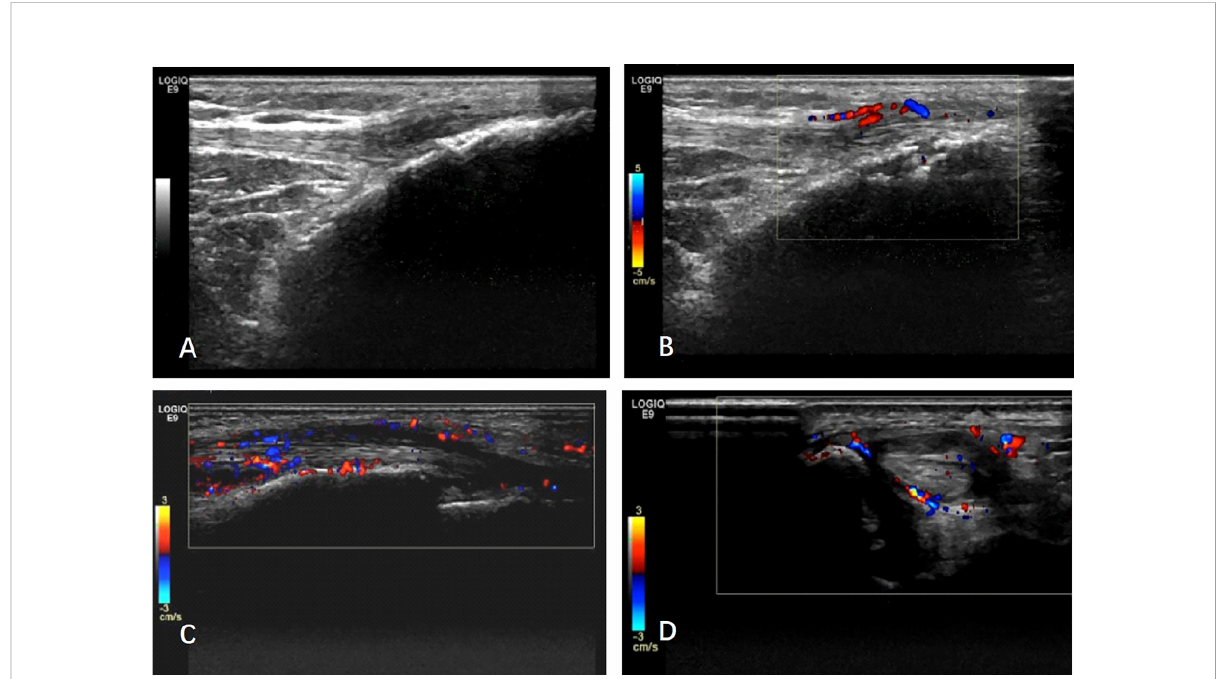
FIGURE 1 The typical ultrasound image of psoriatic arthritis: (A, B) Enthesitis: (A) longitudinal scan of patellar tendon at its distal insertion into the anterior tibial tuberosity. Note the presence of hypoechoic areas, entheseal thickening together with an enthesophyte. (B) B-mode signs of enthesitis are detectable. The image shows evidence of power Doppler signal at the entheseal area, together with erosion. (C, D) Tenosynovitis: longitudinal and transverse scan of anterior tibialis tendon. Note abnormal anechoic and hypoechoic tendon sheath widening with intense power Doppler